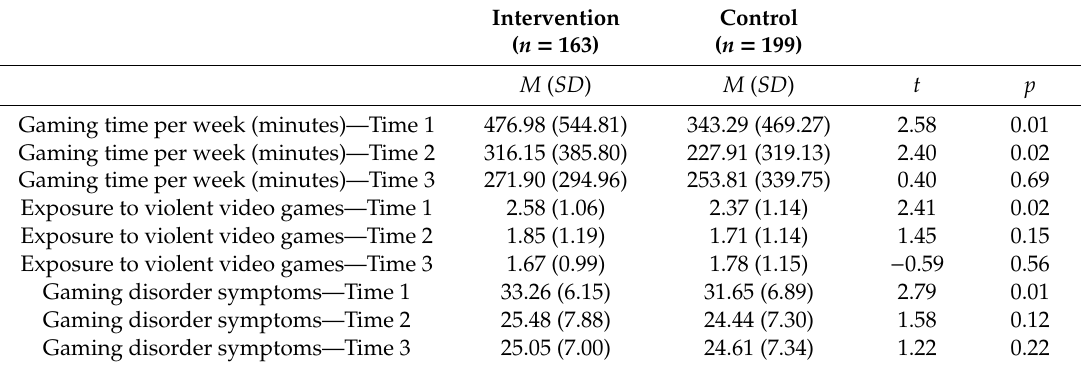
Table 2. Descriptive statistics of three criterion variables by time and condition.